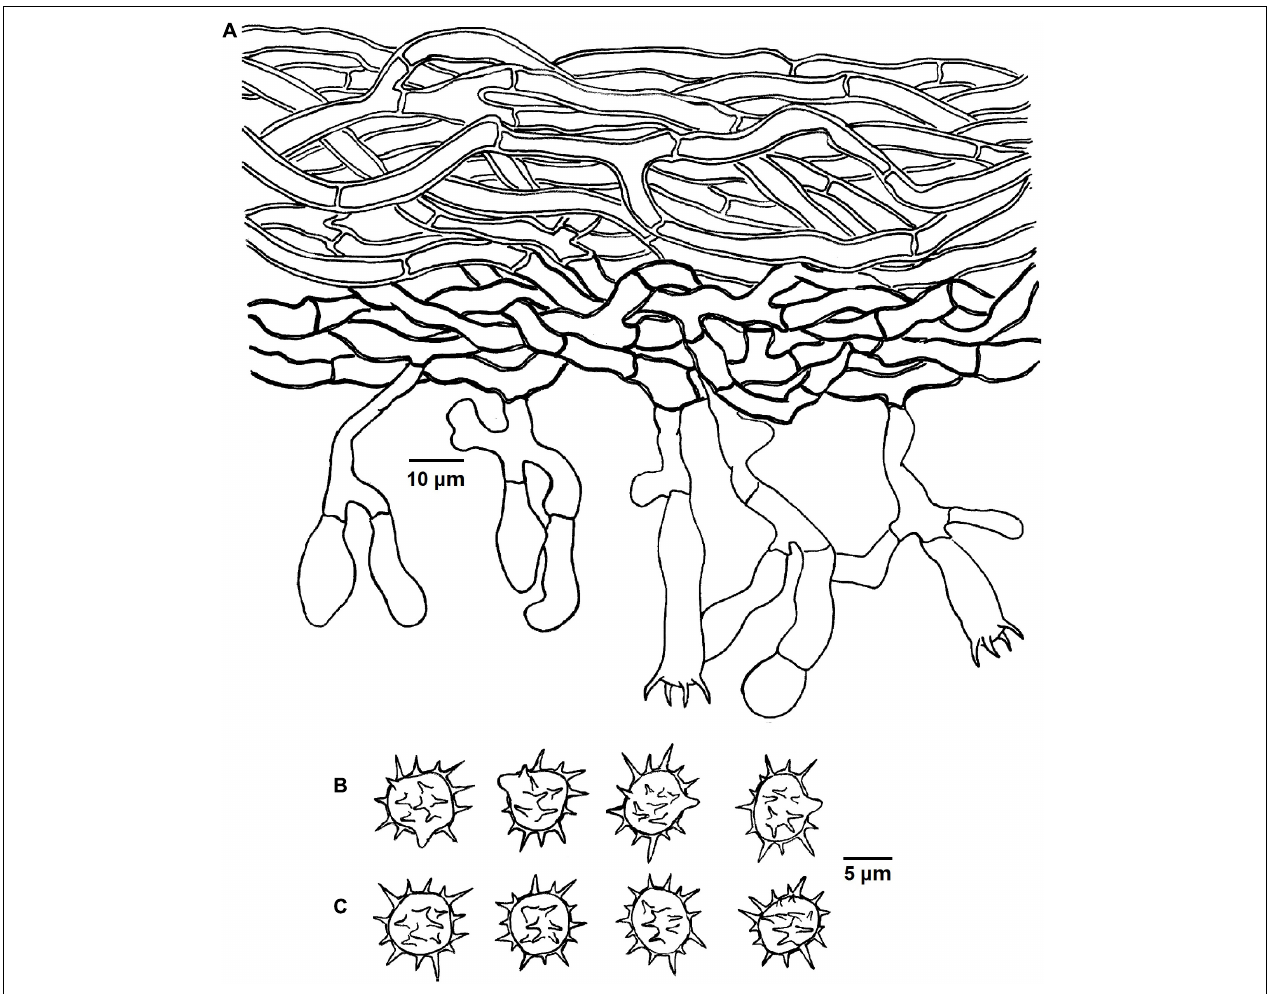
FIGURE 7 | Microscopic structures of Tomentella longiechinula (drawn from Yuan 12687). (A) A section through basidiocarp. (B) Basidiospores in lateral view. (C) Basidiospores in frontal view.